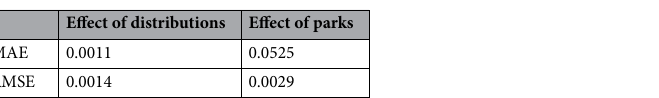
Table 6. The p values of the Friedman test for overall wind speed